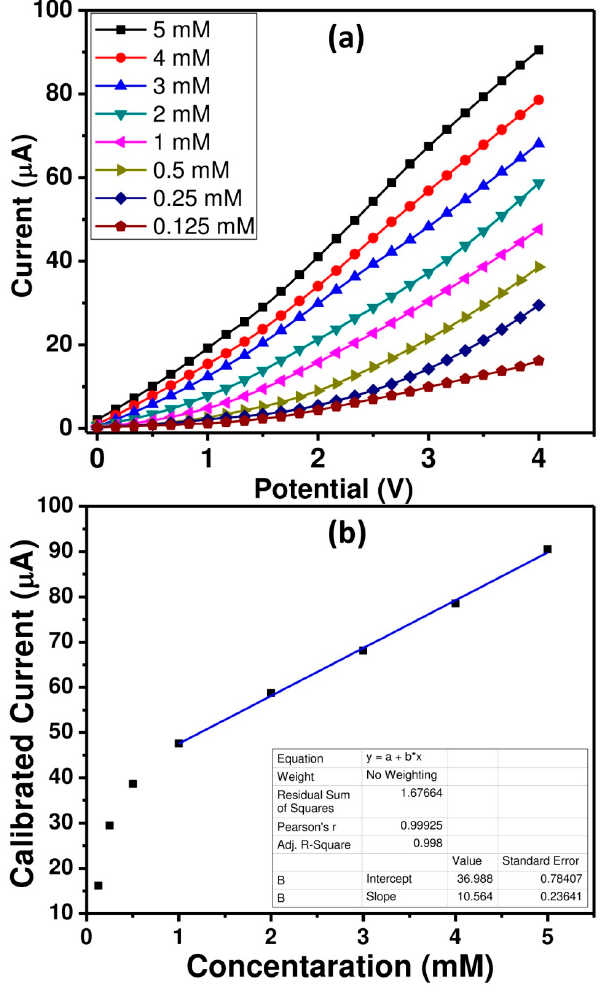
Figure 8. ( a ) I-V responses for various concentrations of picric acid solutions ( b ) Calibration graph for the fabricated ZnO nanopeanut-modified AgE electrochemical